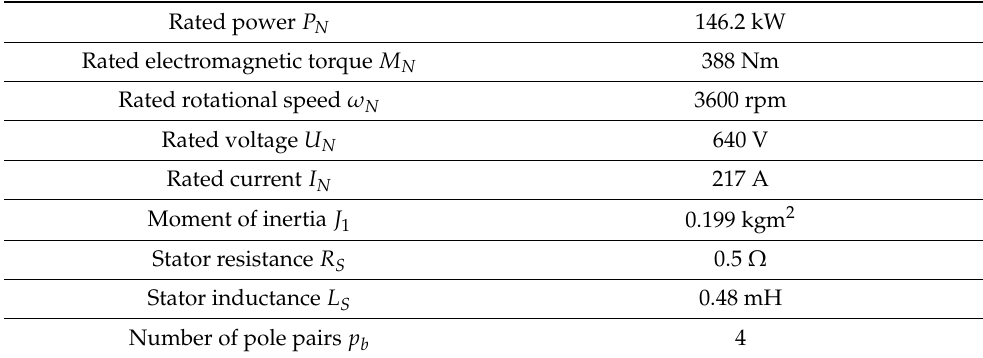
Table 1. List of parameters for PMSM with surface